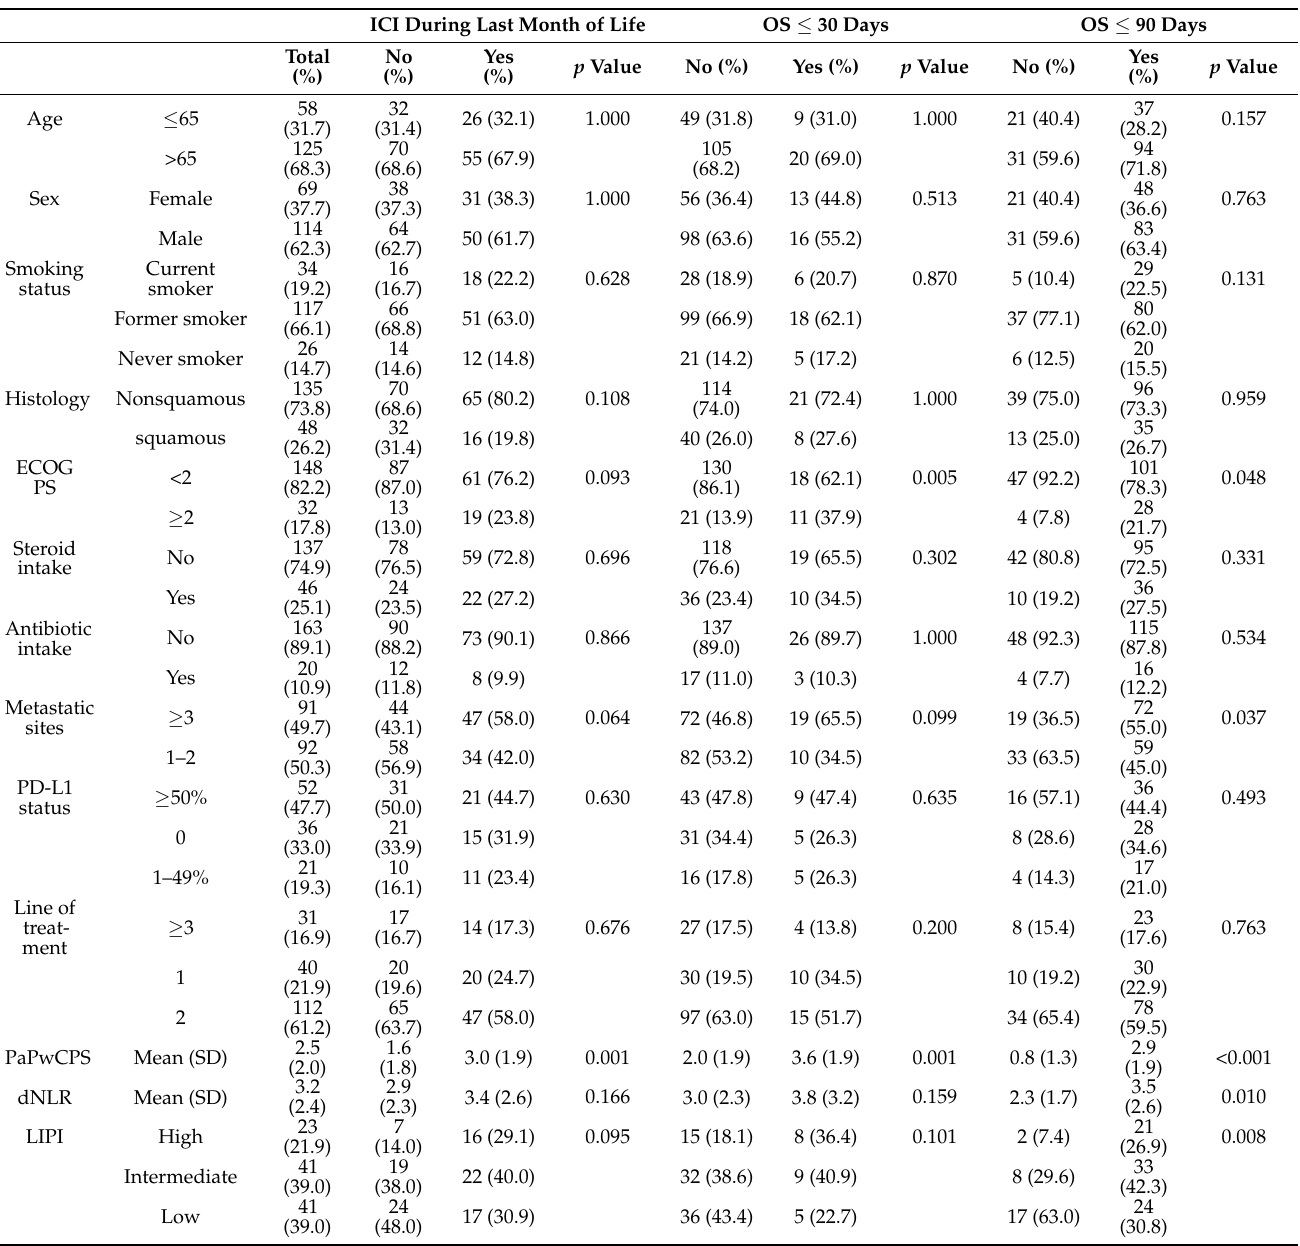
Table 1. Baseline